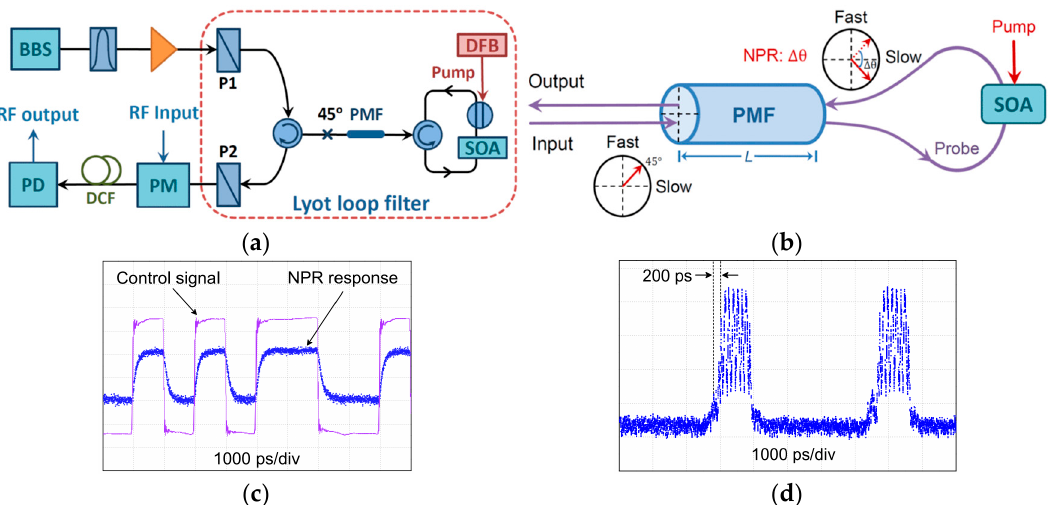
Figure 9. ( a ) Experimental setup of the optically controlled fast reconfigurable microwave photonic dual-band filter for RF signal switching based on nonlinear polarization rotation. BBS: broadband light source. EDFA: erbium-doped fiber amplifier. DFB: distributed feedback laser. SOA: semiconductor optical amplifier. P1–P2: polarizers. PM: phase modulator. PMF: polarization-maintaining fiber. PD: photodetector. DCF: dispersion compensating fiber. ( b ) Operation principle of the optically Purple waveform: 1 Gbps hopping code sequence with a “10101100” pattern. Blue waveform: Corresponding output signal of the SOA that experienced nonlinear polarization rotation. ( d ) Switching